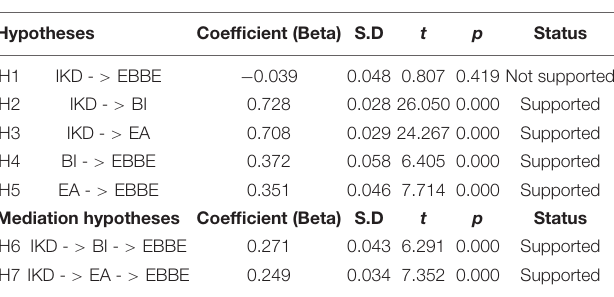
TABLE 6 | Hypotheses